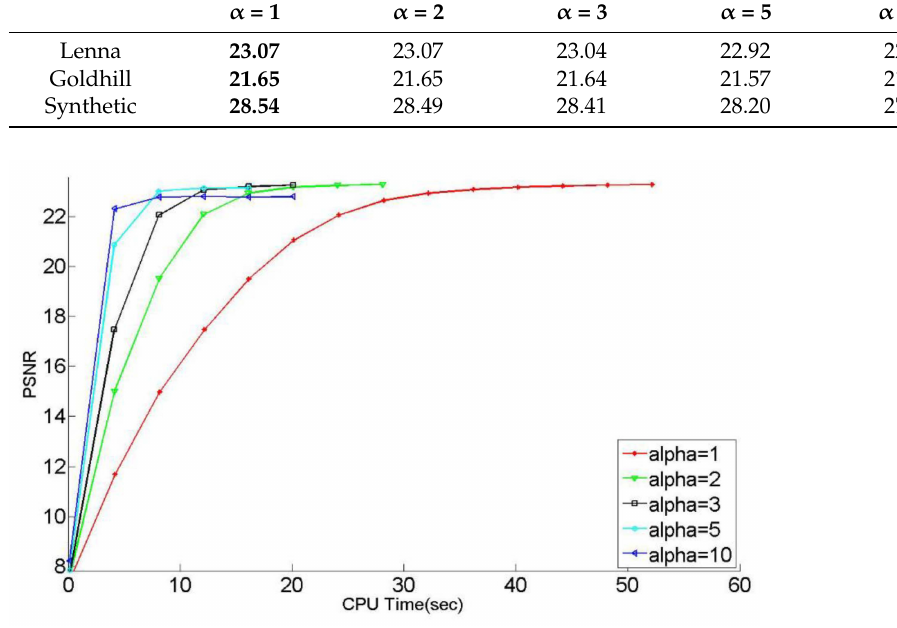
Figure 8. PSNR against CPU time for Lenna image with different α